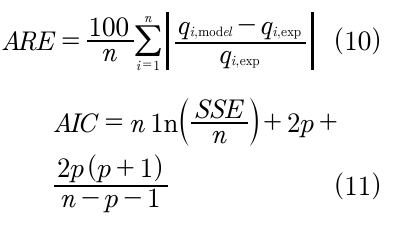
FTIR spectrum of raw kaolin is shown in Figure 3. The main characteristic bands of the kaolinite are highlighted in Figure 3. The bands at 3694 and 3619 cm -1 (OH stretching vibrations), 1114 and 694 cm -1 (Si-O stretching), 1031 cm -1 (Si-O-Si), 1008 and 540 cm -1 (Si-O-Al) and, 912 cm -1 (Al-OH) are typical of kaolinite mineral 56,57 . Bands located at 789, 753 and 468 cm -1 can be attributed to the presence of quartz 57-60 . Vibration at 432 cm -1 can be related to the deformation mode of Si-O or Al-O bonds 61 .